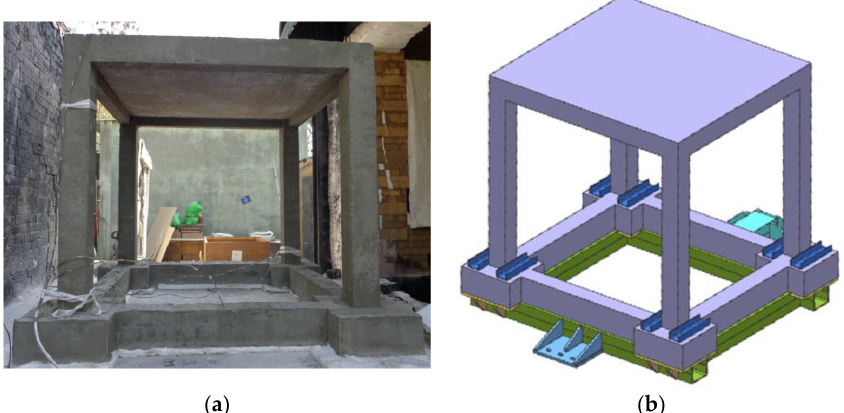
Figure 3. Geometry of the experimentally tested reinforced concrete (RC) frame (Parmar et al. [33]) (all in mm).